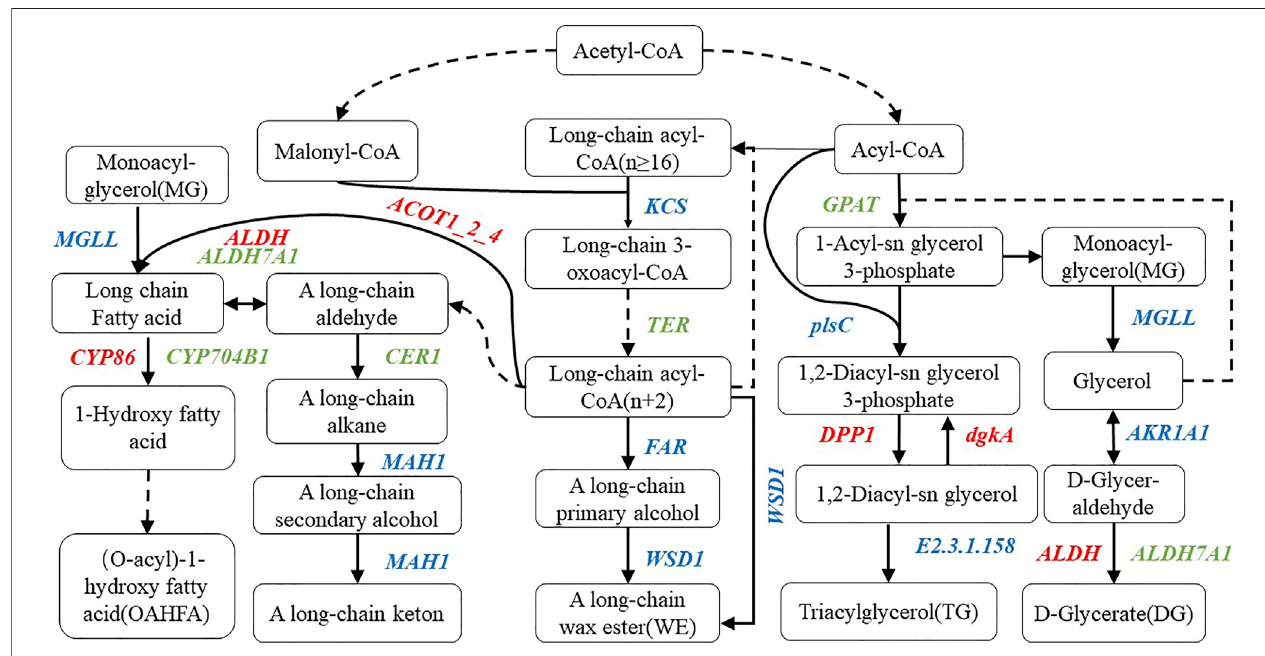
FIGURE 7| Metabolicpathwaymapofwax-relatedlipidsynthesisinwheatepidermis.Therearemetaboliccompoundsinthebox,red-markedenzymesarerelatedto upregulated genes, green-marked enzymes are related to downregulated genes, and blue-marked enzymes are related to both upregulated and downregulated genes.